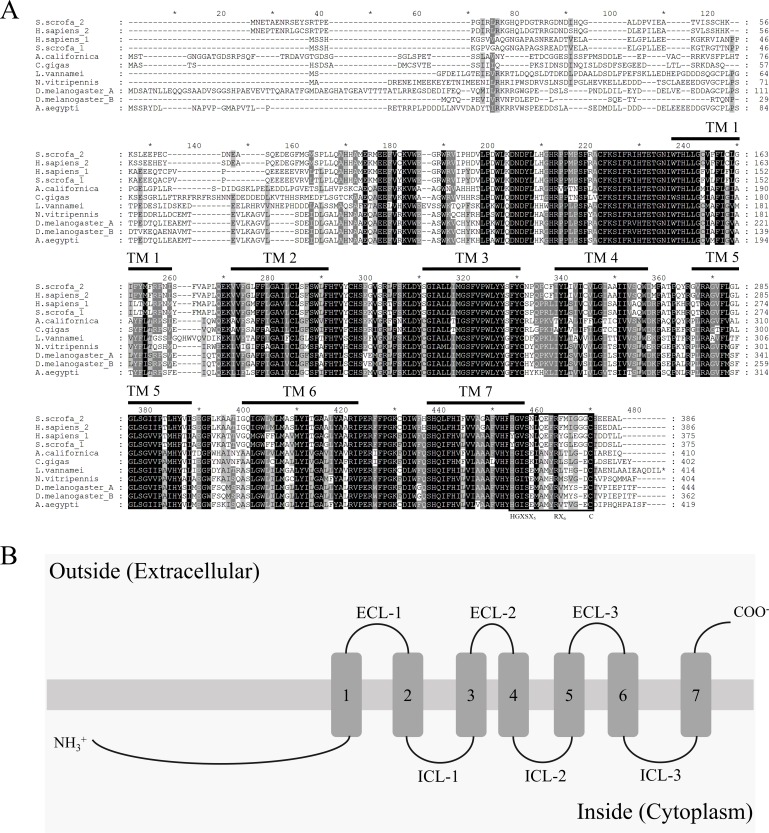
Multiple alignments analysis and topology prediction.(A) Multiple alignment of AdipoRs in various taxa. Conserved amino acid residues were shaded in black (100%) and in grey (above 60%). Seven transmembrane regions shown by the overbars. The conserved residues (HGXSX5RX6C) within the C-terminal region were boxed. The GenBank accession number : Homo sapiens 1, NP_116054; Homo sapiens 2, NP_078827; Sus scrofa 1, AAT72305; Sus scrofa 2, NP_001007193; Aplysia californica, XP_005097206; Crassostrea gigas, XP_011439974; Drosophila melanogasterA, NP_651061; Drosophila melanogasterB, NP_732759; Aedes aegypti, EAT33030; Nasonia vitripennis, NP_001153422 (B) Predicted topology of Liv-AdipoR. Topology was predicted by two programs TopPred 1.10 (http://bioweb.pasteur.fr/seqanal/interfaces/toppred.html) and HMMTOP 2.0 (http://topcons.cbr.su.se/). Predicted structure was depicted by the Microsoft PowerPoint (Microsoft, ver. 2013). ICL 1-3, Intracellular loops 1-3; ECL 1-3, Extracellular loops 1-3.